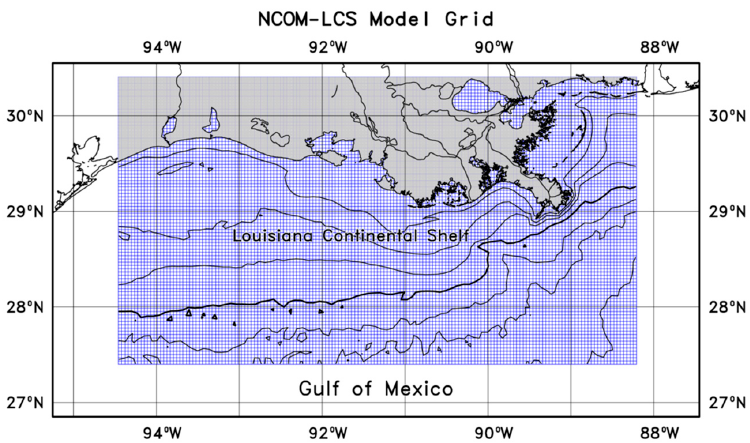
Figure 1. NCOM-LCS model domain and grid (every second gridline shown). The model ocean topography is contoured.